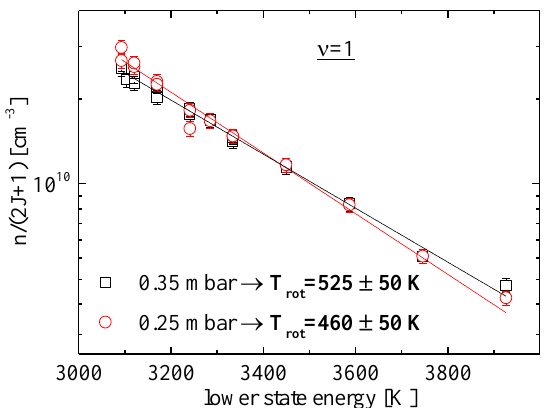
Figure 37. Boltzmann plot of the P and R branch of CO lines of the first hot band for two pressure values, p = 0.25 and 0.35 mbar, P = 3 kW, φ = 50 sccm, CH 4 admixture: 2.5%, CO 2 admixture: 1% [66], © IOP Publishing. Reproduced with permission. All rights reserved.